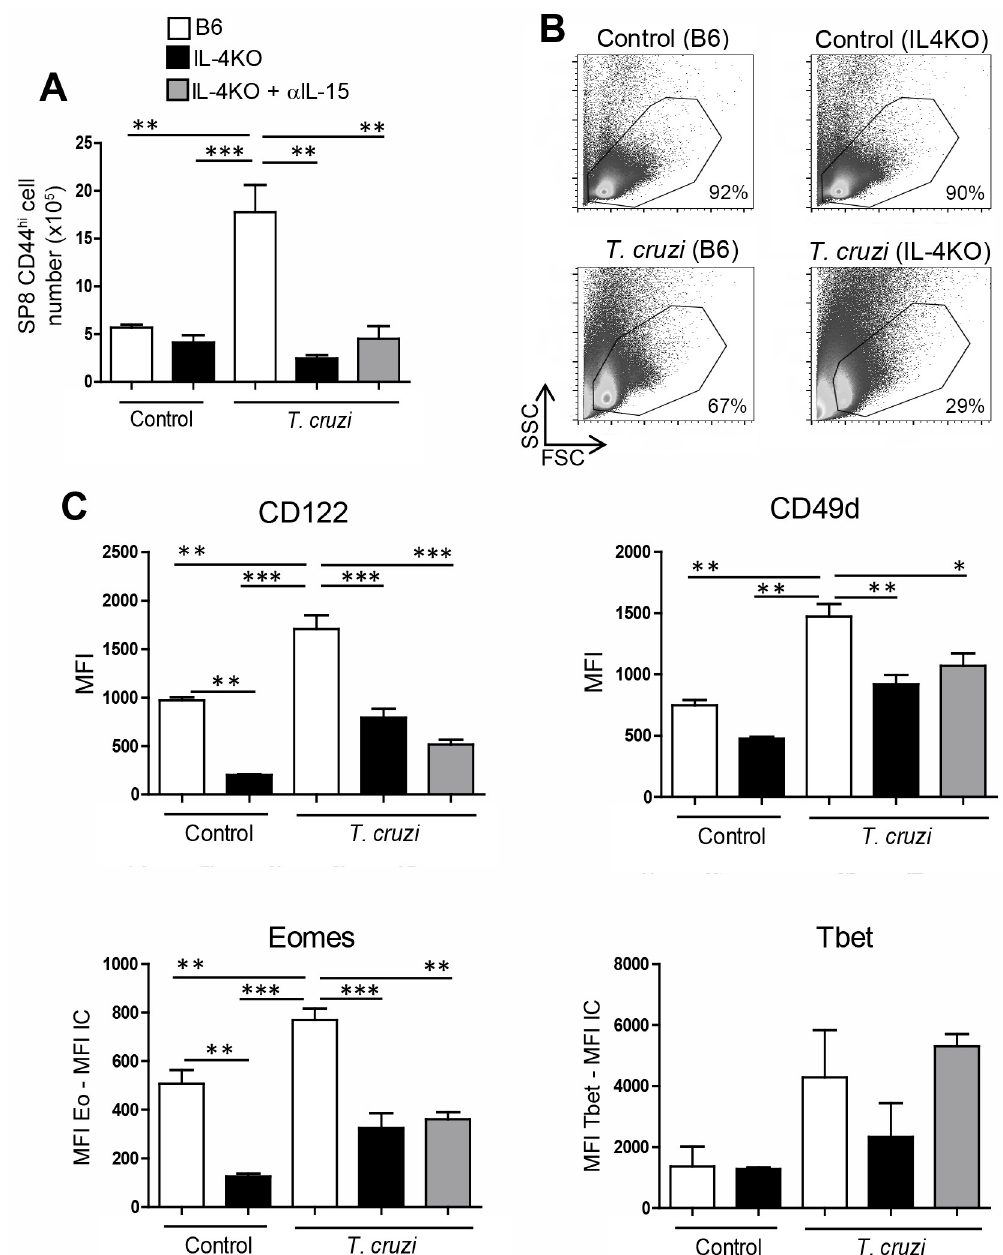
Fig 10. IL-4 expression is important to generate innate CD8+ thymocytes after T . cruzi infection. WT and IL-4KO mice were infected with T . cruzi (Tulahuen) and sacrificed 14 days post-infection (dpi). IL-4KO T . cruzi -infected mice were separated in 2 different groups, one with no treatment and the other was treated with 2 i.p. injections of anti-IL15 antibody (25 μ g of IL-15 per injection) at 10 and 12 dpi. Thymocytes were obtained on day 14 dpi and (A) the total number of SP8 CD44 hi cells was calculated. (B) Representative density plots of one mouse per group that shows the percentage of total viable cells. (C) The expression of CD122 and CD49d was evaluated by flow cytometry in SP8 CD44 hi cells. Eomes or Tbet were measured by intranuclear staining using Flow cytometry analysis expression and were expressed as the difference of the mean fluorescence intensity (MFI) of Eomes or Tbet vs the MFI of the correspondent isotype control (IC) in the SP8 CD44 hi subset. Data are shown as the mean ± SEM. The statistical test applied was a One-way ANOVA. T . cruzi vs the rest of the groups, � p < 0 . 05 , �� p < 0 . 01 and ��� p < 0 . 001 .